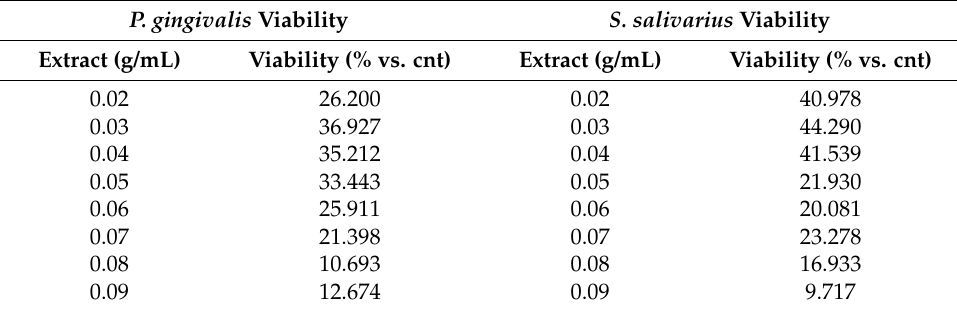
Figure 2. Antibacterial activity of Pelargonium sidoides root extract (PSRE). The extract at all tested concentrations (expressed as g/mL) induced a significant reduction of P. gingivalis ( A ) or S. salivarius ( B ) viability in comparison with the untreated control ( p < 0.01, indicated by the *). Values are represented as the mean ± SD of 16 independent measurements. Table 2. Viability rate of P. gingivalis and S. salivarius after treatment with Pelargonium sidoides root extract (PSRE). Assuming the control as having 100% viability, the survival rate of P. gingivalis resulted in a range between 12% and 36% (left panel) while S. salivarius was between 9% and 44% (right panel).